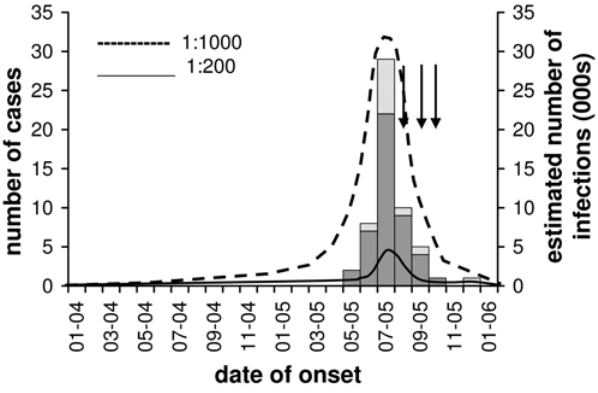
Figure 4 . Temporal distribution of virologically-confirmed (grey bars) and compatible cVDPV cases (dashed bars) in Madura, plotted against the left axis. The estimated number of infections (dotted lines) between the estimated date of the initiating infection and the end of the outbreak is shown against the right hand axis. The number and temporal distribution of these infections represents our best estimate, assuming average case ascertainment of 80%, and constant case to infection ratios of 1:200 (----) or 1:1000 (- - -). Black arrows indicate the dates of NIDs.